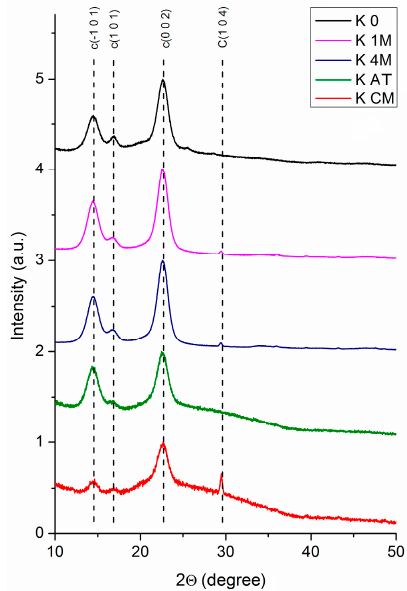
Figure 3. X-ray diffraction (XRD) patterns for Kombucha membranes at different processing stages: K_0 = Kombucha initial membrane; K_1M = Kombucha membrane washed with 1 M NaOH solution; K_4M = Kombucha membrane washed with 4 M NaOH solution; K_B = K_4M after grinding with a blender; K_CM = K_B after grinding with a colloidal mill with recirculation; K_AT = K_CM after atomization; c = cellulose peaks; C = CaCO 3 impurity. (a.u.—arbitrary units).